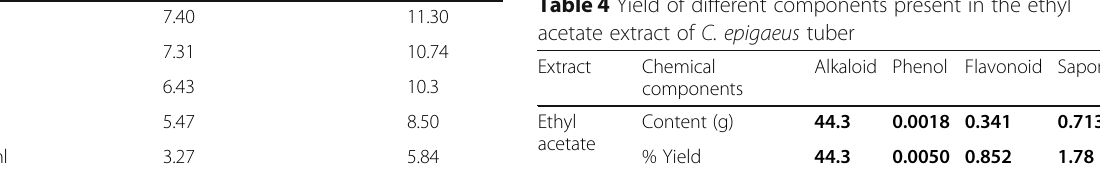
Table 3 Effective dose estimation of ethyl acetate extract of C. epigaeus tuber Concentration